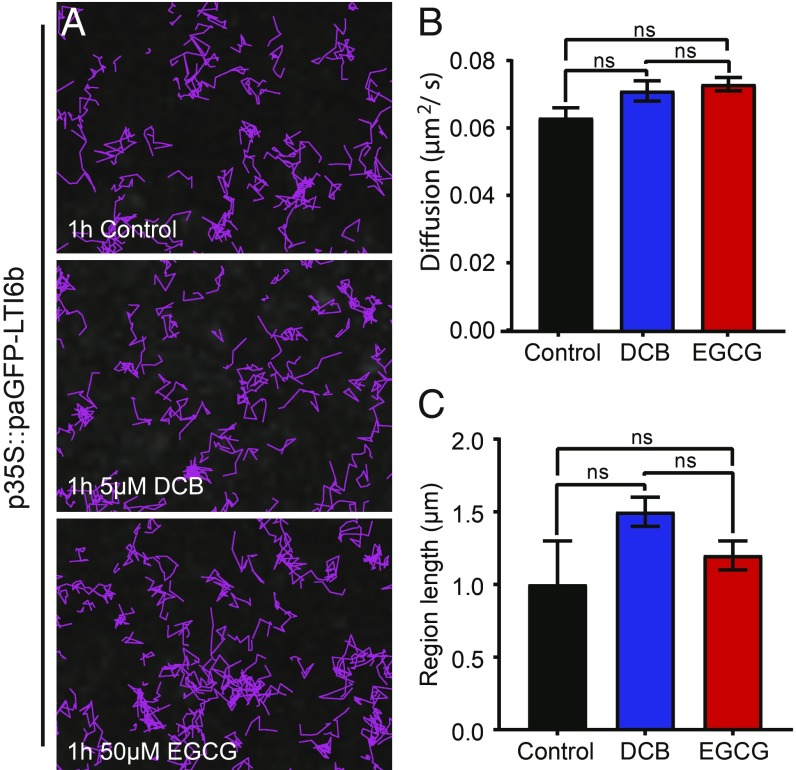
Single particle tracking reveals little effect of cell wall perturbation on paGFP-LTI6b dynamics. DCB was used to perturb cellulose synthesis and EGCG was used to perturb pectin methylation status of hypocotyl epidermal cells. (A) p35S::paGFP-LTI6b in control, and after 5 µM DCB and 50 µM EGCG treatments for 1 h each. Particles tracked over 60 s. (B) Constrained diffusion rate (µm2/s) of proteins in the membrane tracked over 4 s. (C) Constrained region length (µm) of proteins in the membrane during 4 s. ns, not significant.